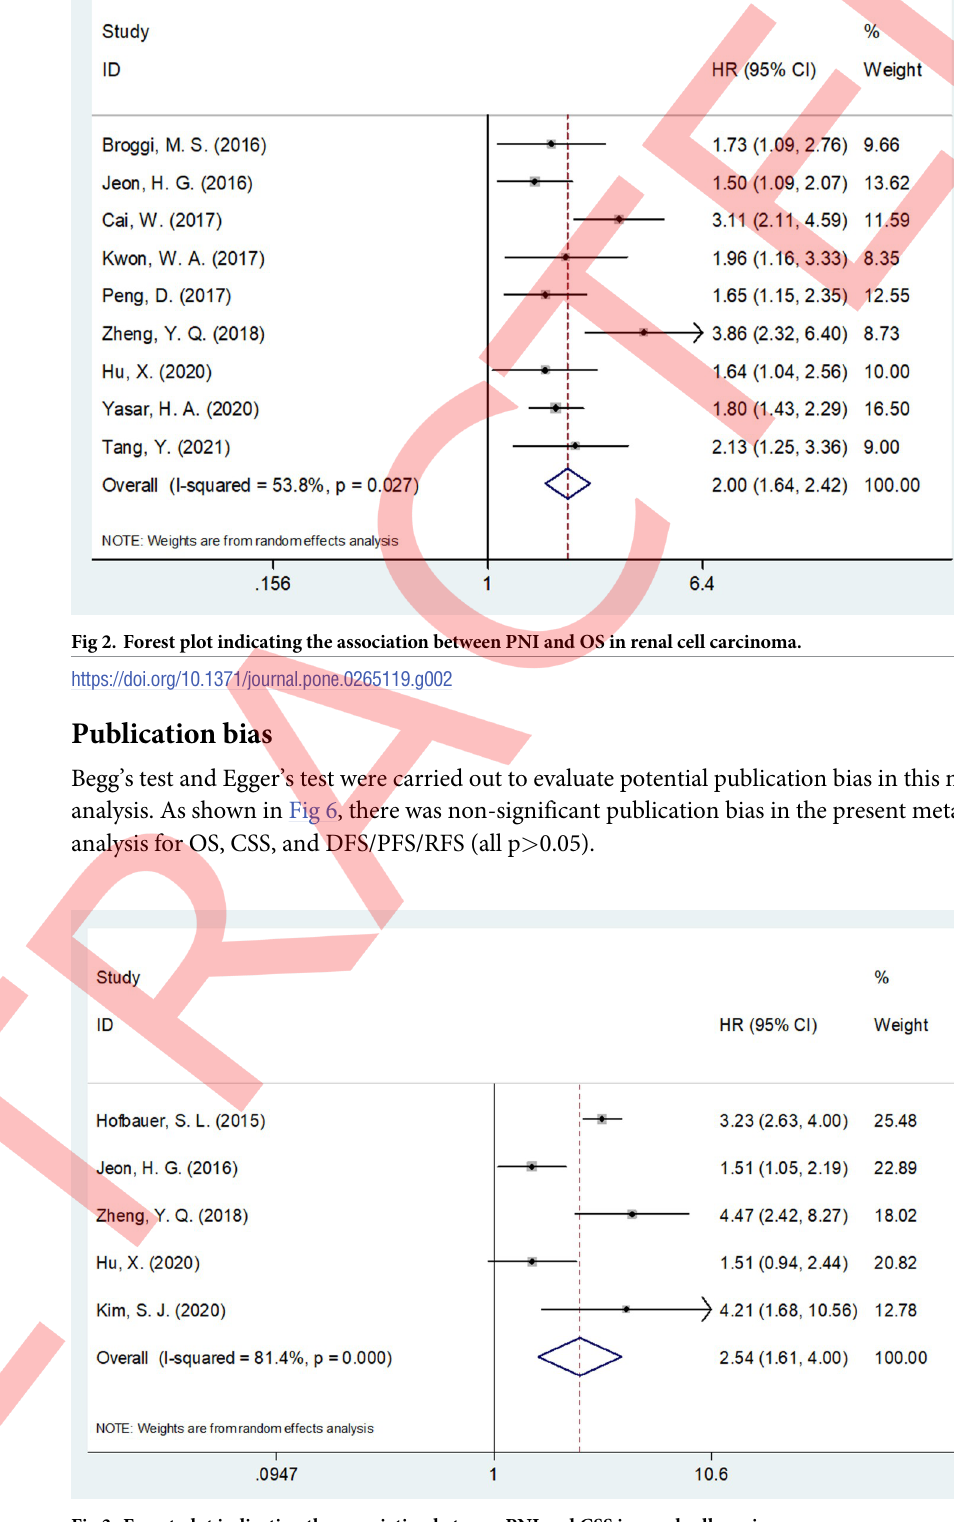
Fig 3. Forest plot indicating the association between PNI and CSS in renal cell